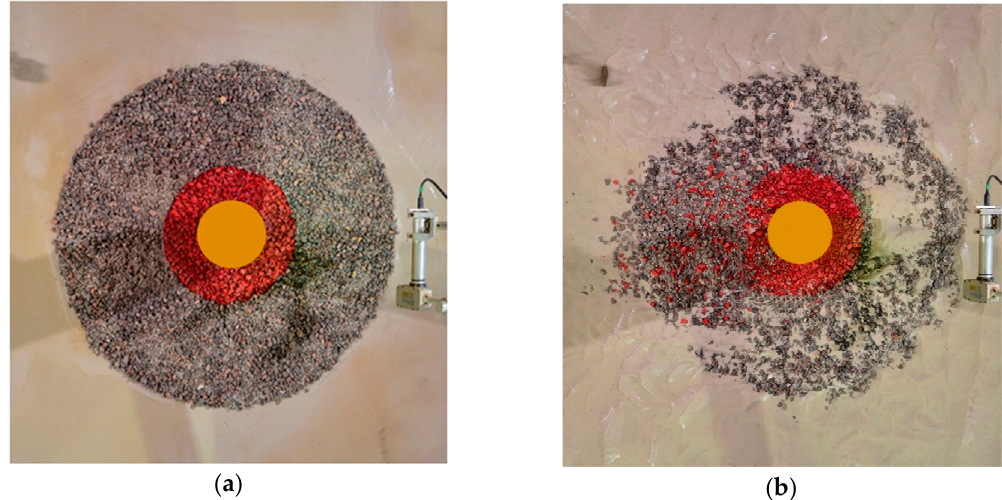
Figure 17. Merged picture of the scour protection scale model Tests 04 before ( a ) and after ( b ) the test. The current propagation in this set of figures is from right to left.